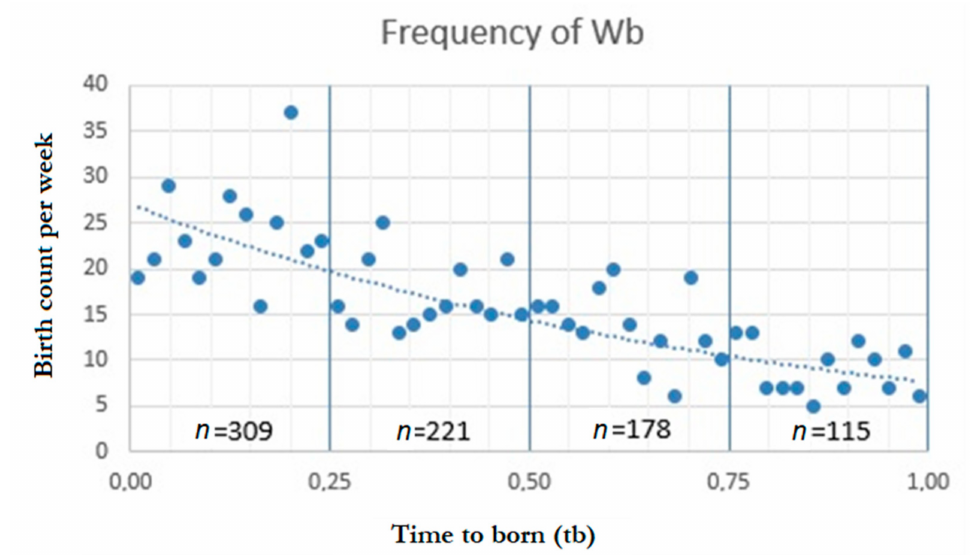
Figure 2 represents the Poisson regression fit line of the total number of players for each week of birth (Wb) and divided by quartiles.